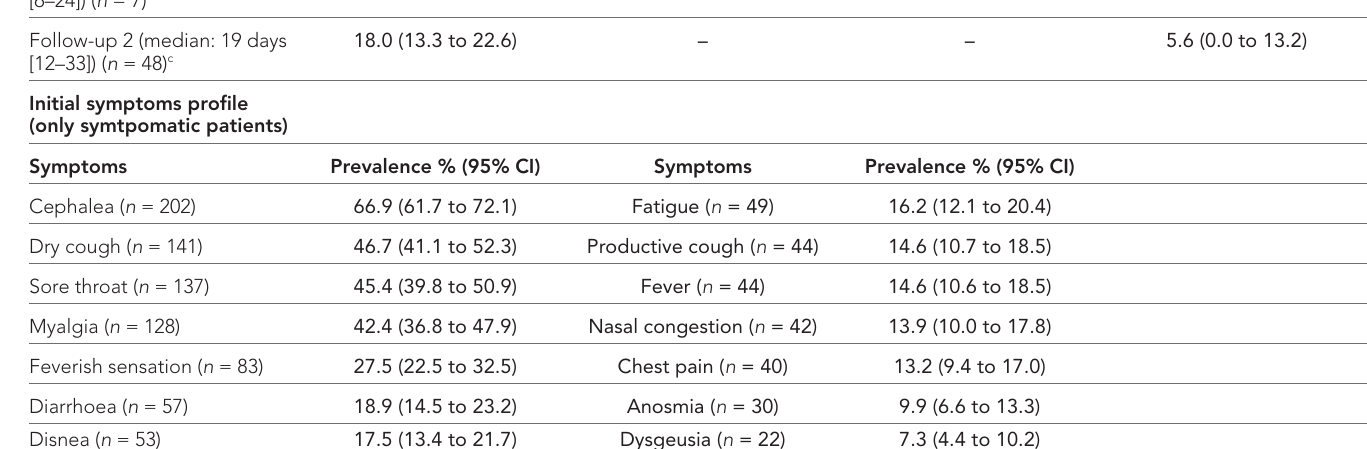
Symptomatic patients ( n = 304,